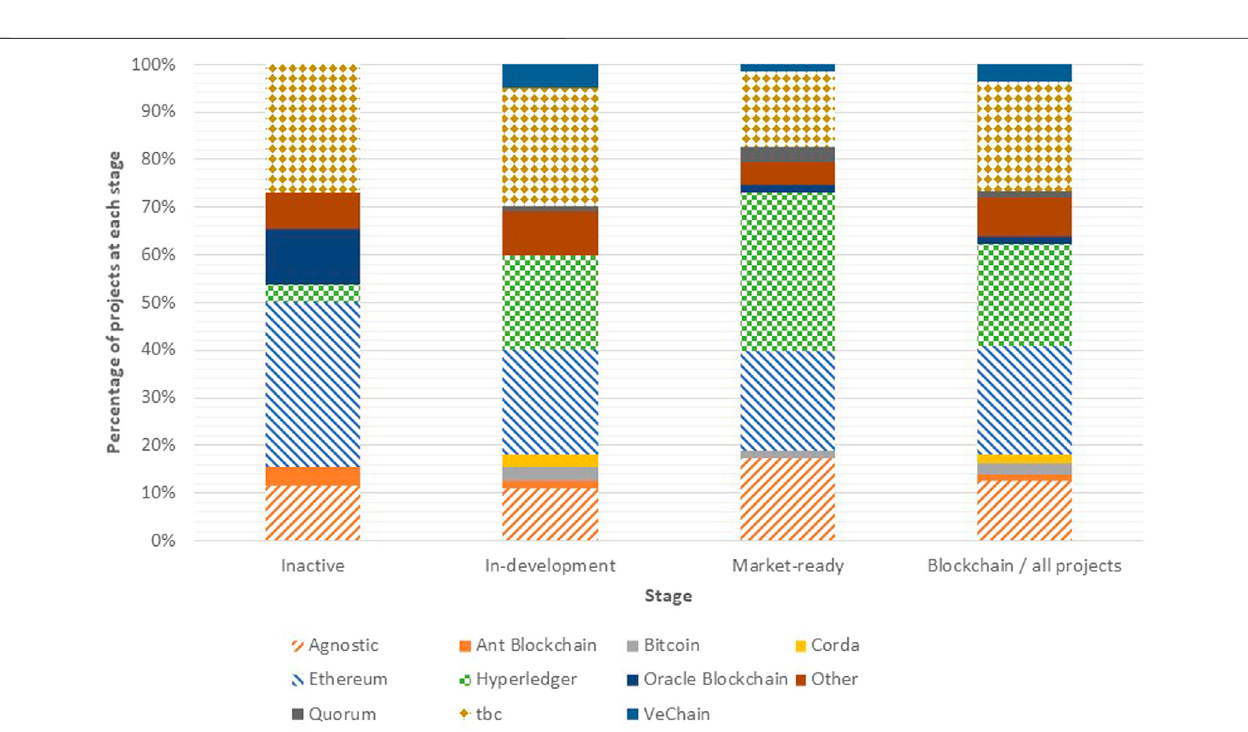
FIGURE 5 | The percentage of projects using a particular blockchain based on the status of the project.